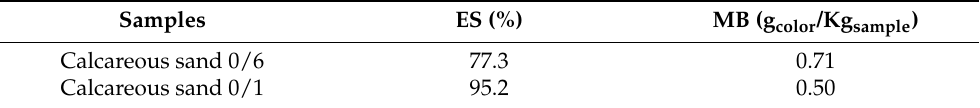
Table 9. ES value (expressed in percentage) [37] and methylene blue (MB) value (expressed by the ratio between g of the color and the kg of the sample) [36] for the sand samples analyzed.